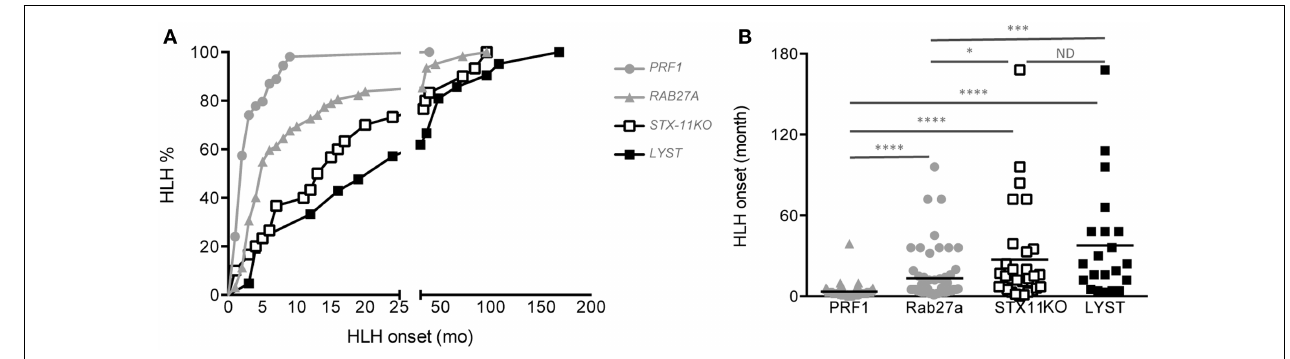
a log-rank test; * p < 0.05 for FHL4 vs. GS2 patients; *** p < 0.001 for GS2 vs. CHS patients; **** p < 0.0001 for FHL2 vs. GS2, FHL2 vs. FHL4 and FHL2 vs. CHS; ND = no statistical differences were observed between FHL4 vs. CHS patients.The onset of HLH was analyzed with a one-way ANOVA. * p < 0.05; *** p < 0.001; *** p < 0.0001. Mutations in PRF1 , RAB27A , and STX11 are detailed in Ref. (44), and mutations in CHS1/ LYST are detailed in Table 3